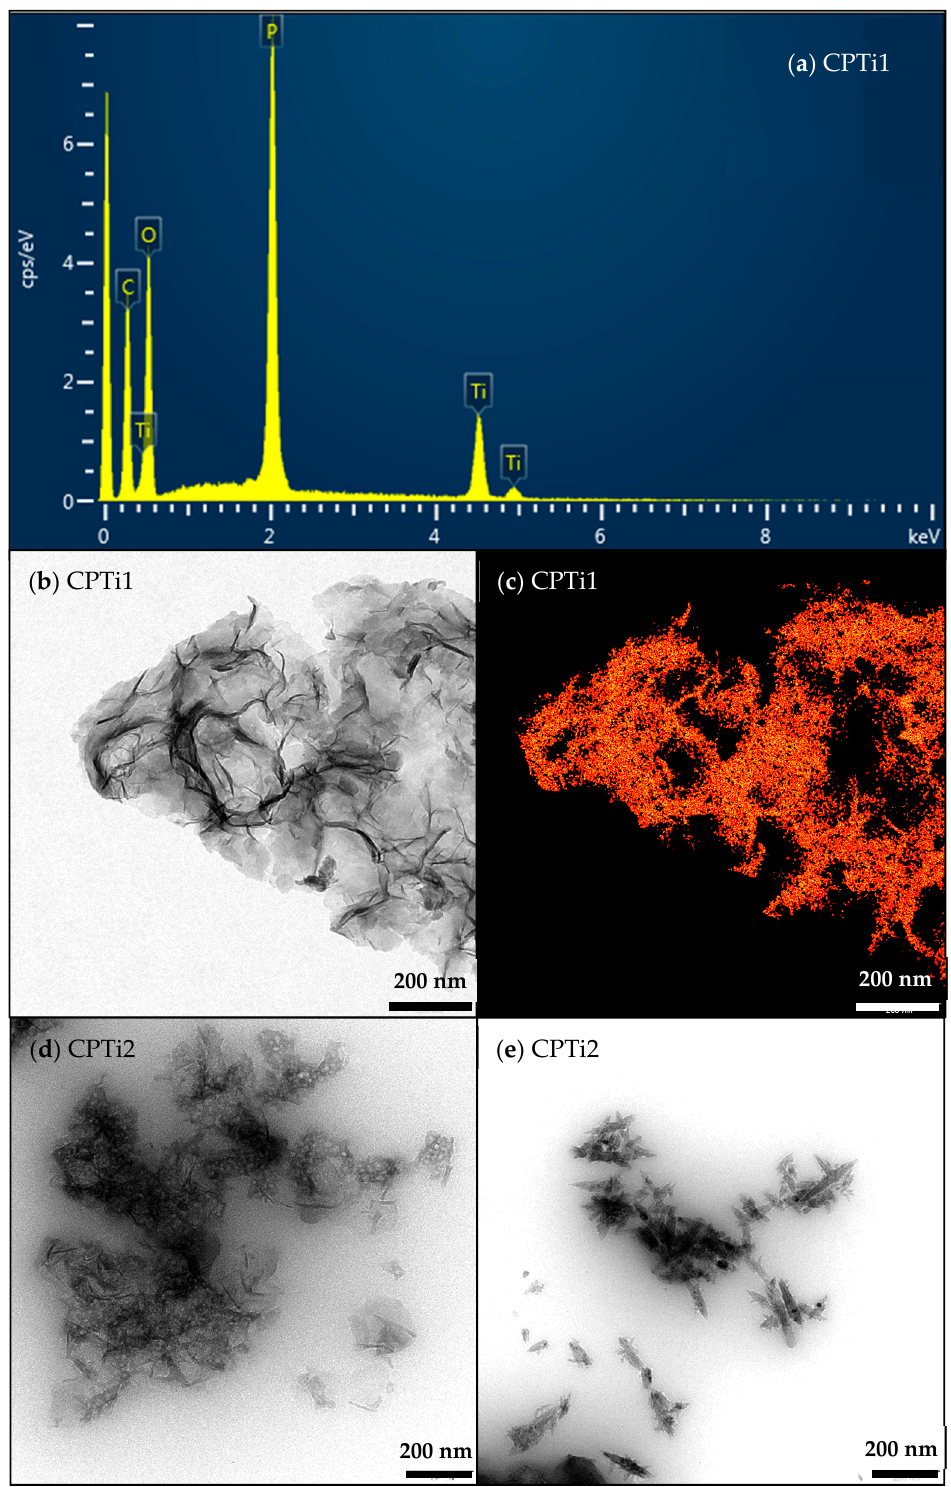
Figure 5. High resolution transmission electron microscopy (HRTEM) characterization of CPTi composites: ( a ) energy dispersive X-ray (EDX) analysis, ( b , d , e ) micrographs and ( c ) Ti-mapping.